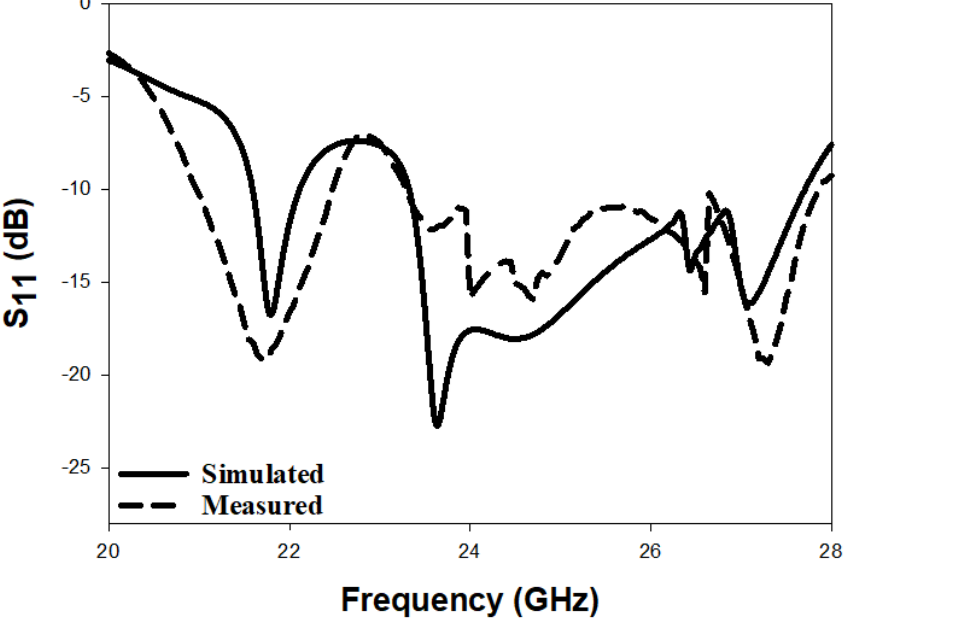
Figure 19. Reflection coefficient of a circularly polarised integrated hemispherical DRA and a perforated substrate.